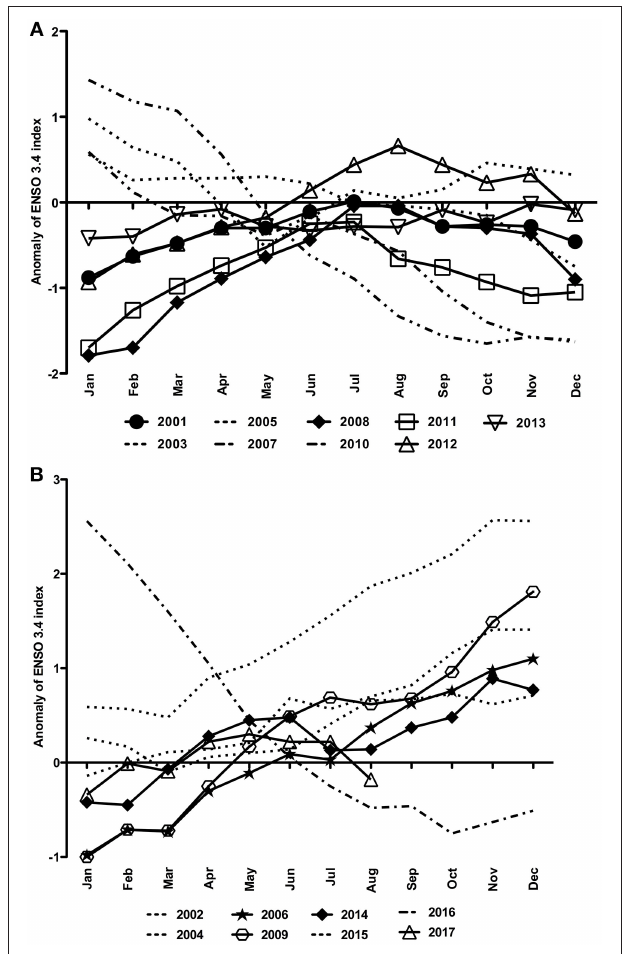
FIGURE 5 | Anomalies of the ENSO3.4 index for the time series of 2001–2017 split into (A) La Niña years and (B) El Niño